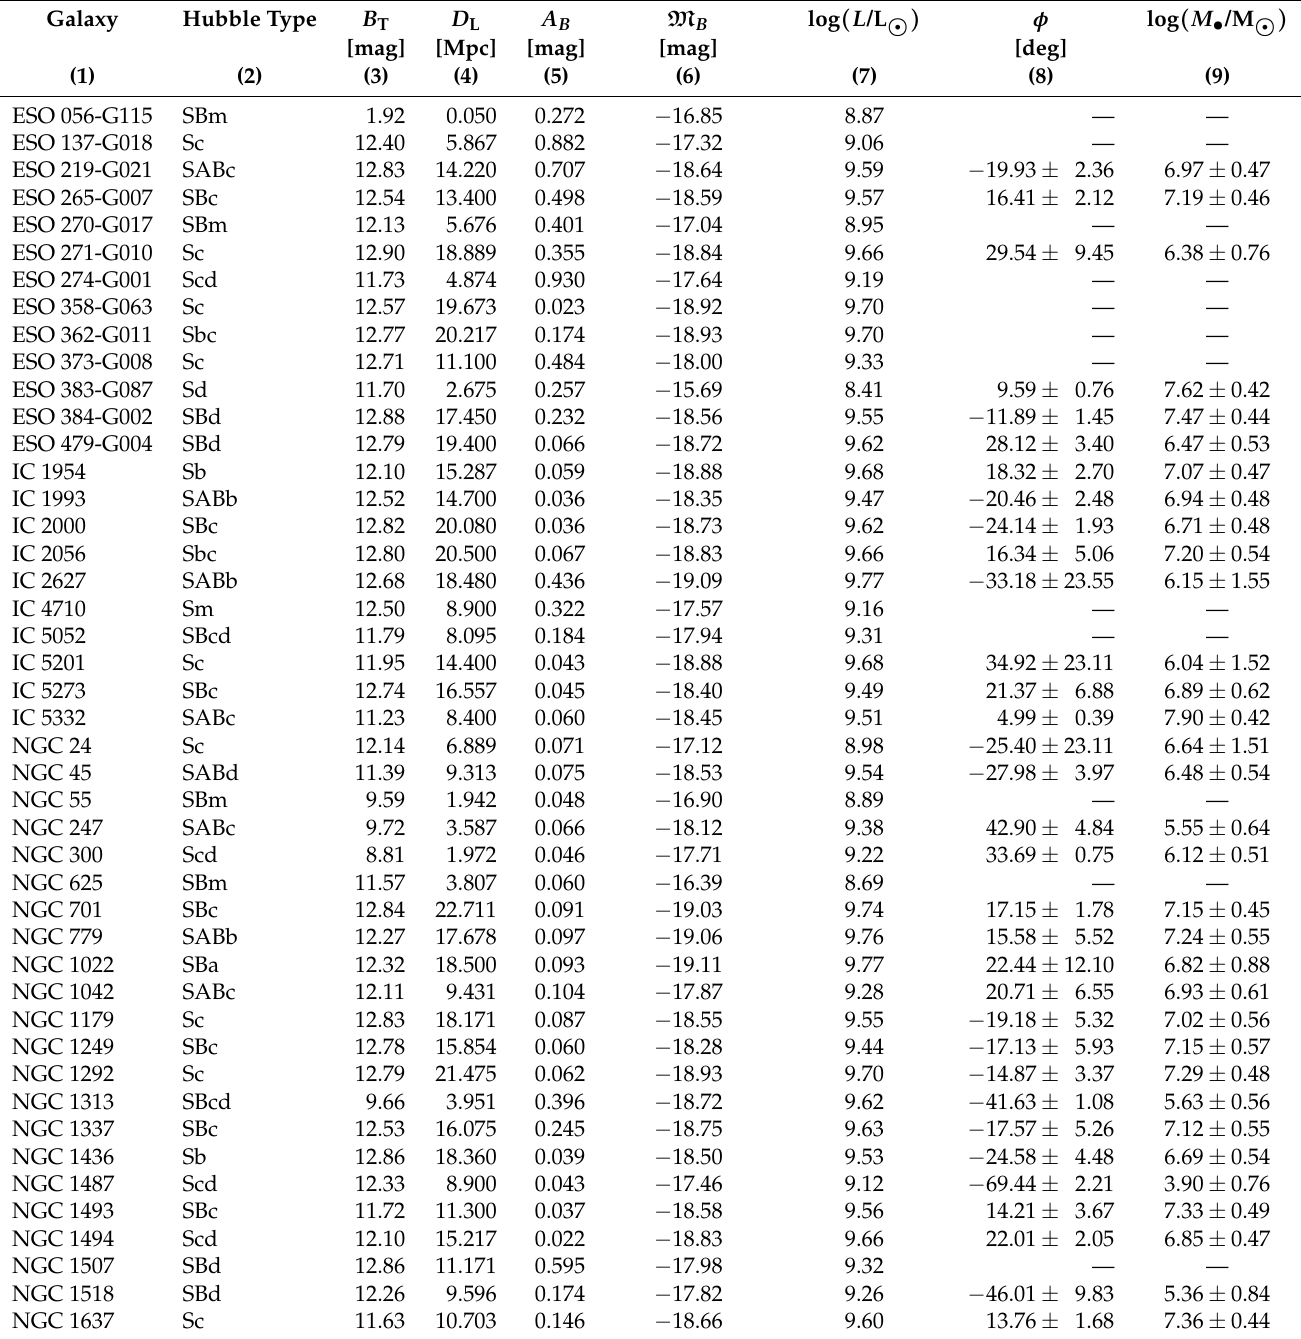
Table 1. The subsample of 74 spiral galaxies (55 measured + 19 with unmeasurable pitch angles) from the CGS [54]